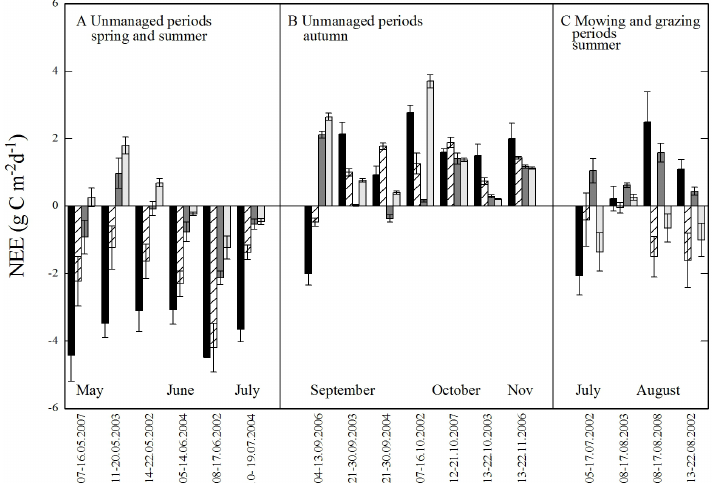
Fig. 3. Daily integrated average net ecosystem exchange of CO 2 (NEE; gCm − 2 s − 1 ) of ( A, B ) unmanaged, and ( C ) mowing and grazing periods from 2002 to 2008. Groups of bars refer to the same 10-day time periods for all sites as explained in the text. NEE was calculated using Eq. (2) based on 10-day periods during which at least one complete day of chamber measurements was available, and using site-specific microclimatic conditions as input. Sites are indicated by black bars (valley bottom meadow), criss-cross bars (mountain meadow), dark grey bars (pastures) and light grey bars (abandoned). Error bars represent standard errors and reflect the temporal variability in meteorological input parameters to Eq. (2).